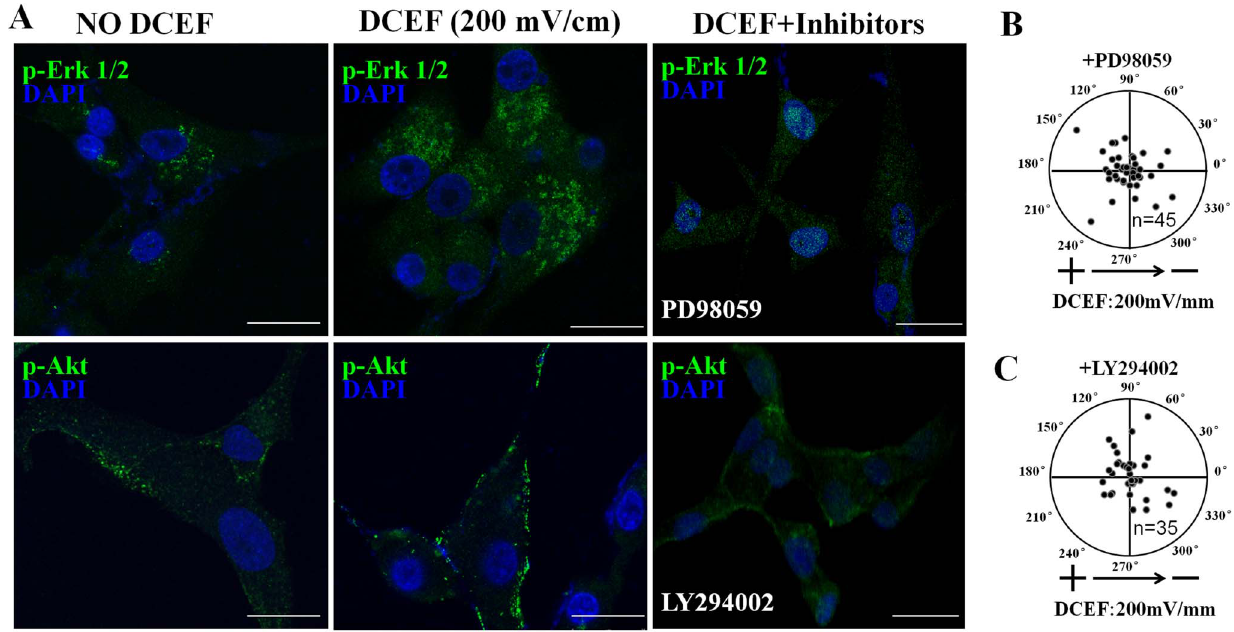
Figure 6. Superoxide-mediated electrotaxis depends on the activation of Akt and Erk1/2. DCEF would induce the phosphorylation of Erk1/2 and Akt, and the activation of Erk1/2 or Akt were reduced by 20 m M PD98059 (inhibitor of Erk) or 20 m M LY294002 (inhibitor of Akt) respectively (A). DCEF-induced directional migration of U87 cells was also significantly decreased by PD98059 (B) or LY294002 (C). Bar=25 m m.